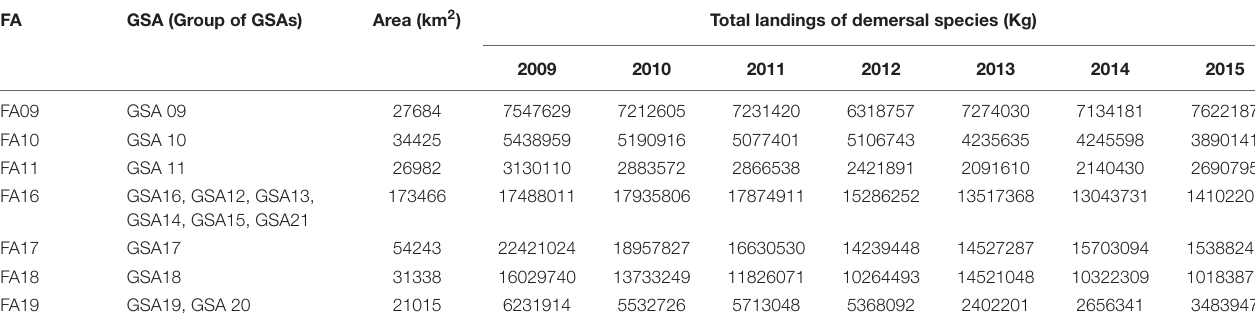
TABLE 1 | Data for total landings of demersal species (source: Italian National Program of Data Collection in the Fisheries Sector) and estimated surface of the corresponding Fishing Area for each official GSA-specific fleets of Italian trawlers. FA GSA (Group of GSAs)